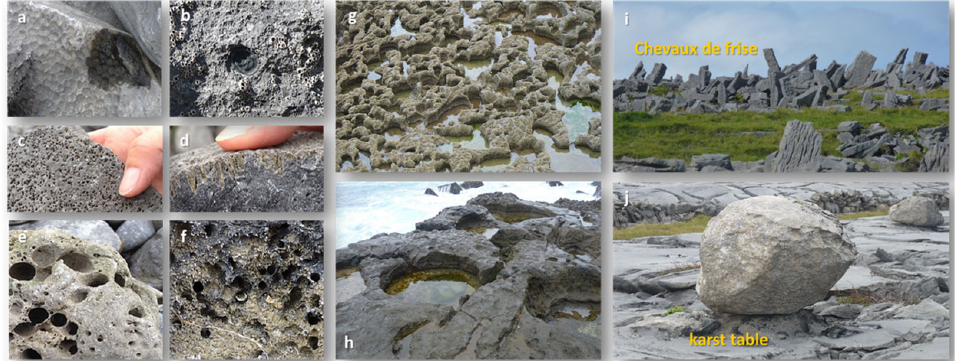
Figure 7. ( a – h ): Bio ‐ erosional signatures on bedrock and boulders allow for identification of their origin precisely: ( a ) sea urchin home places; ( b ) limpet ( Patella sp.) home place; ( c , d ) sponge borings ( Cliona sp.); ( e , f ) boring bivalves ( Hiatella arctica ); ( g ) rock pools with barnacle cover at mhw; ( h )